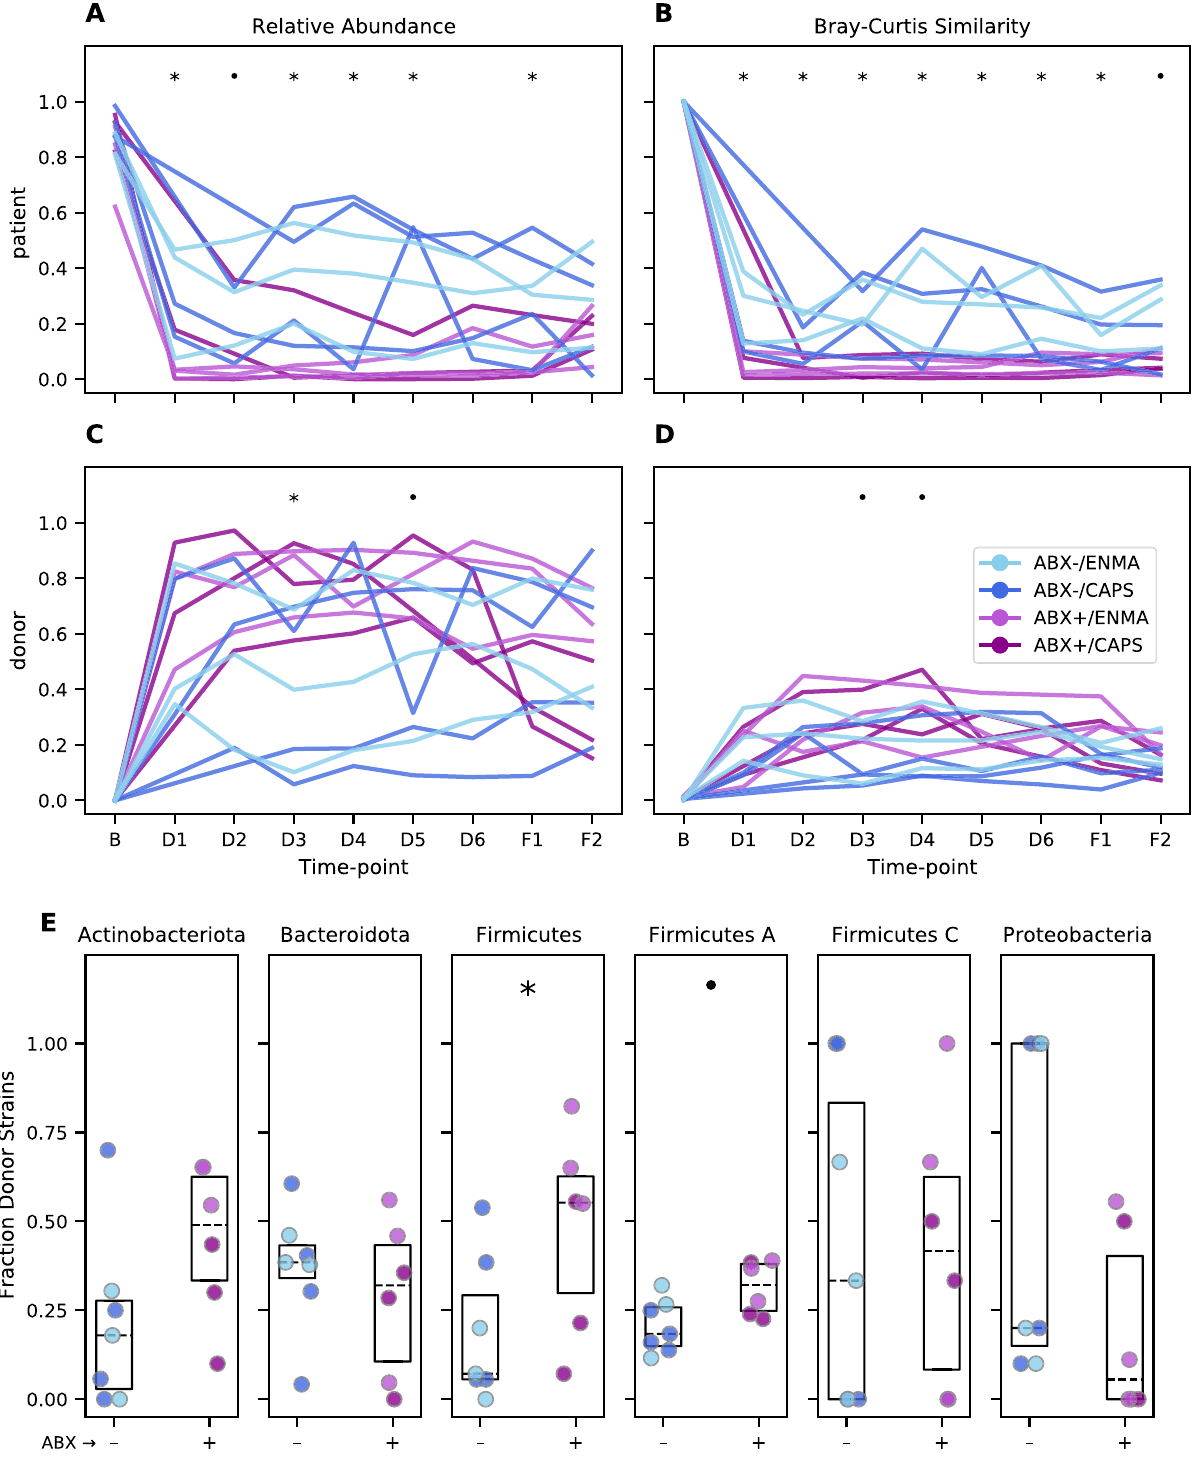
Figure 3. Greater community perturbation and engraftment of donor strains following FMT treatment in antibiotic-pretreated patients. (A,C) Abundance of strains specific to each patient’s baseline sample (A) or specific to each donor sample (C) relative to the patient’s total strain populations over the course of treatment. (B,D) BC similarity (1—BC dissimilarity) between each patient’s sample and that patient’s own baseline (B) or their assigned donor (D) . (E) Fraction of donor strains detected in each patient’s fecal samples at F1. Each dot represents a patient, colors are as in (A–D) . Boxes span the interquartile range with the median also marked (dotted line). In all panels, symbols indicate individual time points (A–D) and taxa (E) with p-values less than 0.1 (·) or 0.05 (*) by MWU test for differences between patients who did or did not receive antibiotic